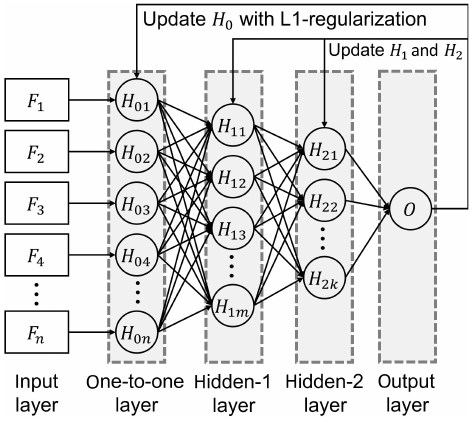
Fig. 5 Structure of the feature selection neural